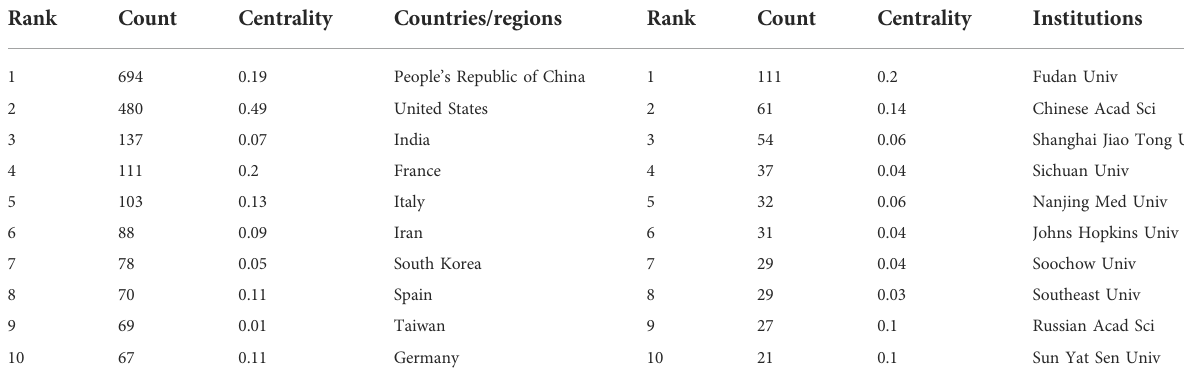
TABLE 1 Top ten countries/regions and institutions for related publications.